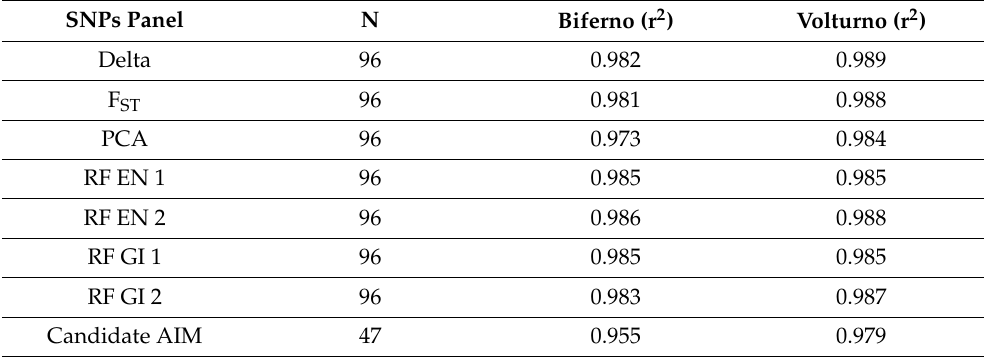
Table 3. Coefficient of determination values (r 2 ) calculated between the ancestry percentages using the full set of SNPs and the AIM panels in case study populations. N is the number of SNPs in each